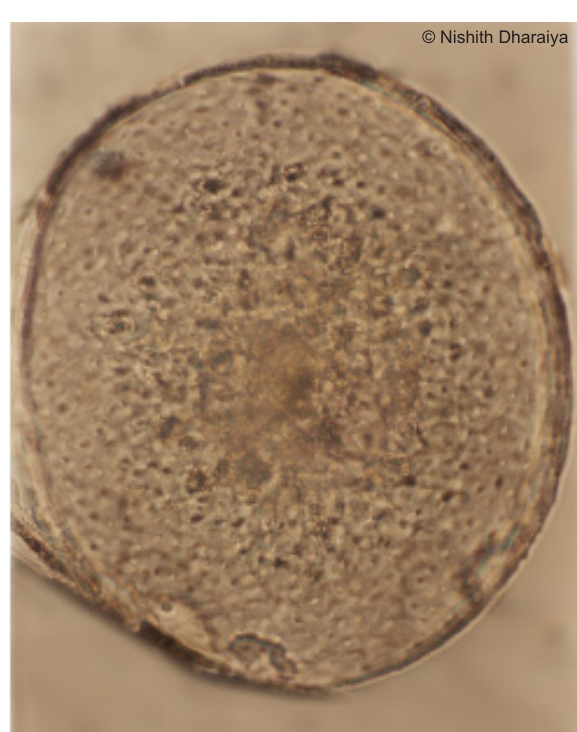
Image 2. Cross section of hair of